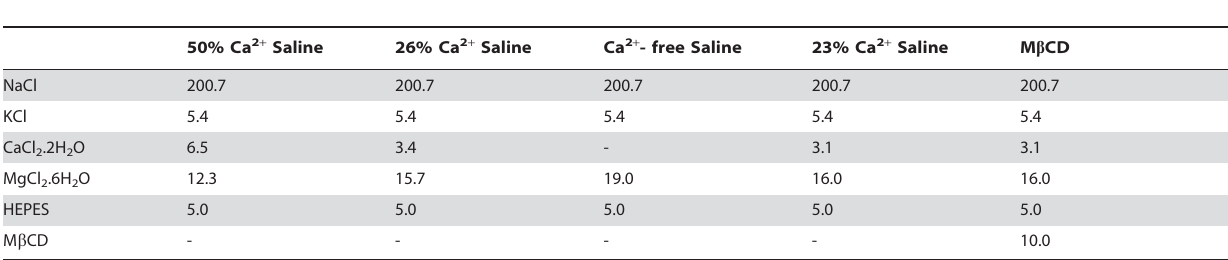
Table 2. Chemical composition of salines used. All values are expressed in